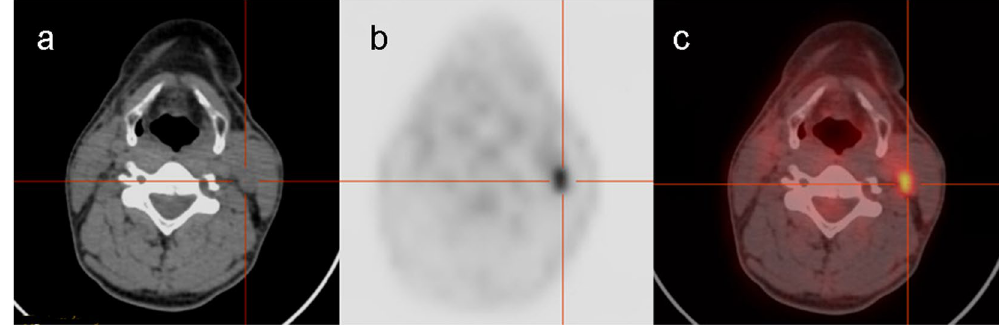
Figure 1. A true-positive lesion on the left neck region was detected by 18 F-FDG PET/CT. A 35-year old woman underwent total thyroidectomy with central lymph node dissection on the right neck region and radioiodine ablation for remnant PTC and thyroid tissue. 131 I-WBS obtained 5 days after an oral administration of 3.7 GBq of 131 I showed negative finding. Six months after ablation, the patient had negative Tg ( < 0.1 ng/mL) but abnormal TgAb of 108 IU/mL at TSH suppression status. Subsequently, during the follow-up 3.5 years later, TgAb level progressively increased from 108 IU/mL to 623 IU/mL. 18 F-FDG PET/CT revealed 18 F-FDG-avid nodal lesion with SUV max of 4.7 in the left neck ( a , b and c , crossing line). Surgical pathology confirmed the metastatic nodal lesion from PTC after left neck dissection. The patient had markedly decreased TgAb level afterwards.